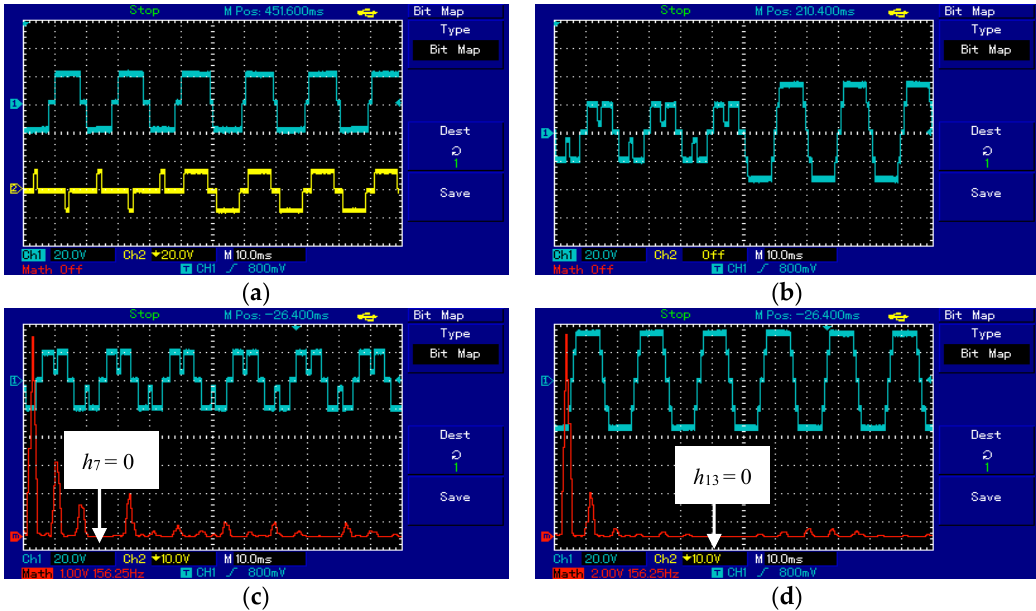
Figure 9. Results of the second case study at V DC1 = 20 V, V DC2 = 14 V, and x = 0.7, in which the seventh and the 13th harmonic orders are removed and the fundamental component is controlled by applying a step change in MI from 1.22 to 0.65: ( a ) V U and V L , ( b ) resulting output voltage, and output voltage spectra at ( c ) MI = 1.22 and ( d ) MI = 0.65.